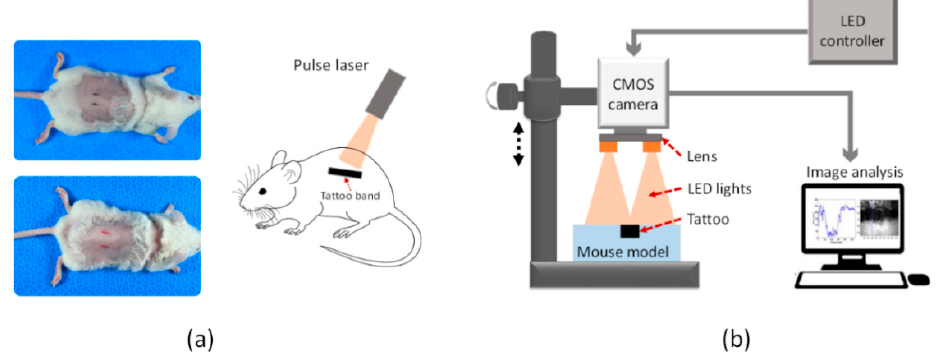
Figure 1. Experimental setups of ( a ) in vivo laser tattoo treatment and ( b ) analysis of tattoo contrast with LED-assisted CMOS camera.